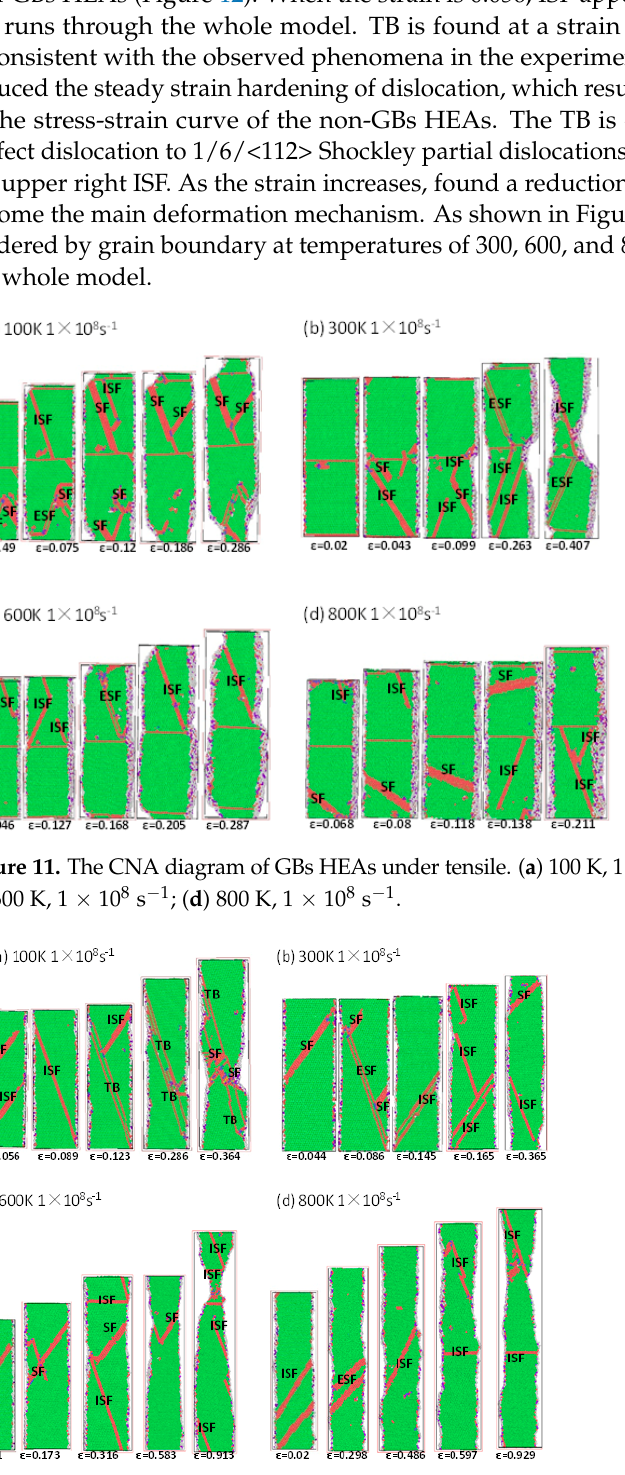
Figure 12. The CNA diagram of non-GBs HEAs under tensile. ( a ) 100 K, 1 × 10 8 s − 1 ; ( b ) 300 K, 1 × 10 8 s − 1 ; ( c ) 600 K, 1 × 10 8 s − 1 ; ( d ) 800 K, 1 × 10 8 s − 1 . The microstructure of dislocation lines Σ 3 GBs HEAs (Figure 13) and non-GBs HEAs (Figure 14) at different temperatures (100, 300, 600, and 800 K) were researched. Disloca- tion type includes mainly green 1/6<112> Shockley partial dislocations, a small account of 1/6<110> Stair-rod, 1/2<110>perfect dislocation, and 1/3<111> Hirth dislocations. Draw a DXA diagram of Σ 3 GBs HEAs at different temperatures (Figure 13), 1/6<112> Shockley partial dislocations always start nucleation near grain boundaries and form a dislocation loop. Dislocations expand with the increase in strain. With the increase in dislocation den- sity, if it slips to the grain boundary, it is hard to slip and stack at grain boundaries. There- fore, dislocation entanglement and dislocation accumulation near grain boundaries. Fig- ure 14 shows the motion of the dislocation line of the non-GBs HEAs at different temper- atures. Dislocations appear randomly at the origin of non-GBs HEAs. The dislocation has been expanded smoothly in non-GBs HEAs. The dislocation density at 100 and 300 K is greater than 600 and 800 K. As the temperature increases, the movement of dislocations increases, and the annihilation of dislocations occurs, resulting in a decrease in dislocation density. Figure 13. The DXA diagram of GBs HEAs under tensile. ( a ) 100 K, 1 × 10 8 s − 1 ; ( b ) 300 K, 1 × 10 8 s − 1 ; ( c ) 600 K, 1 × 10 8 s − 1 ; ( d ) 800 K, 1 × 10 8 s − 1 .